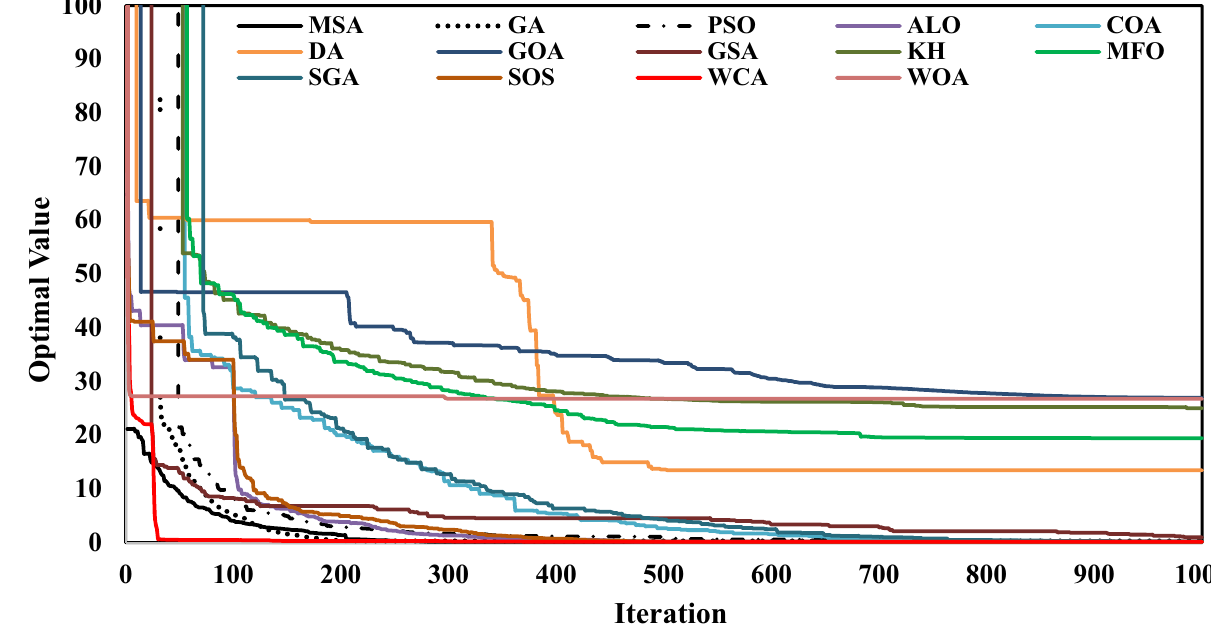
Figure 2. The convergence rate of utilized algorithms in optimization of Karun-4 hydropower reservoir.